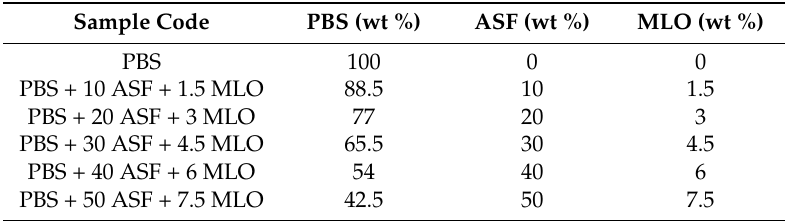
Table 1. Formulations and sample coding of poly(butylene succinate)/almond shell flour/ maleinized linseed oil (PBS/ASF/MLO)